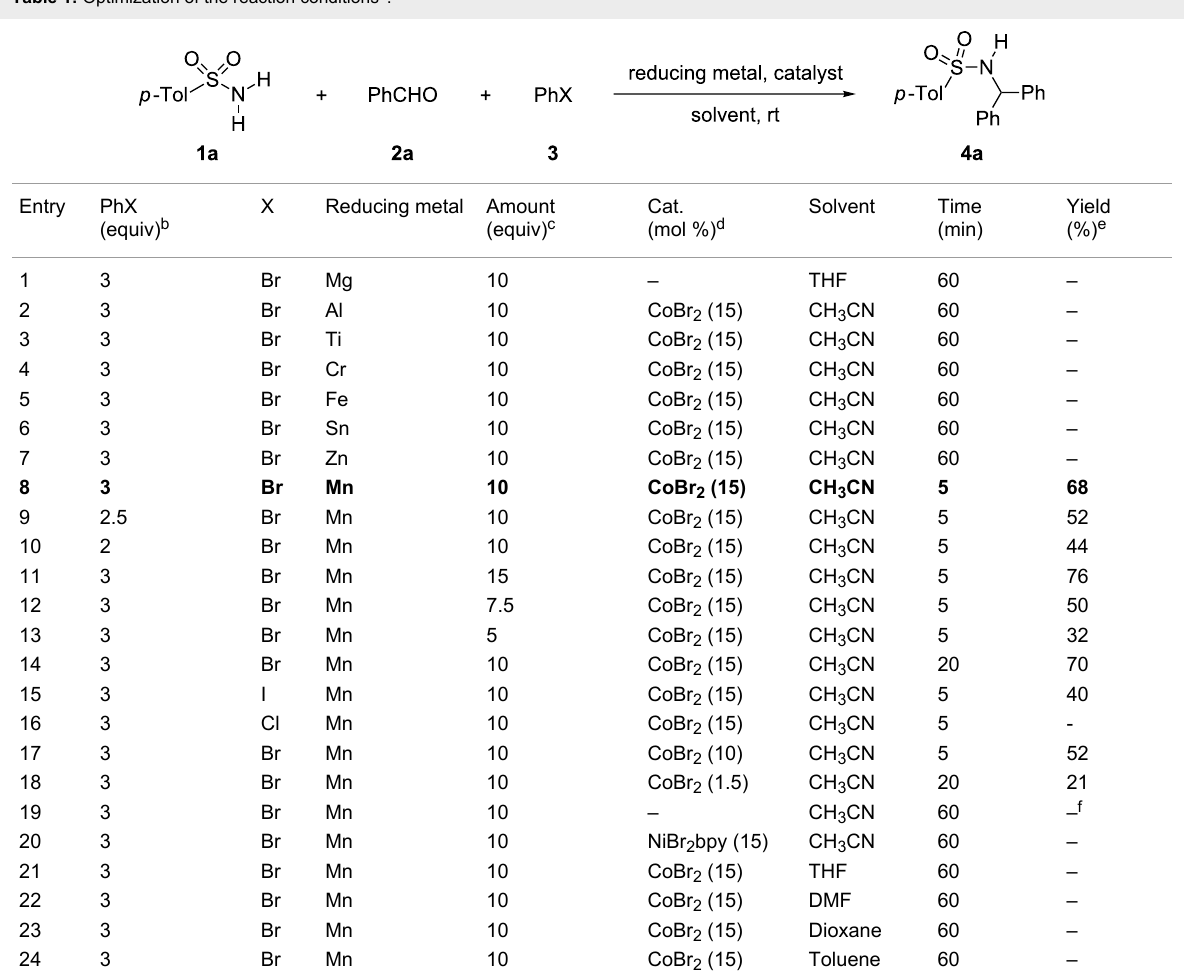
Table 1: Optimization of the reaction conditions a .